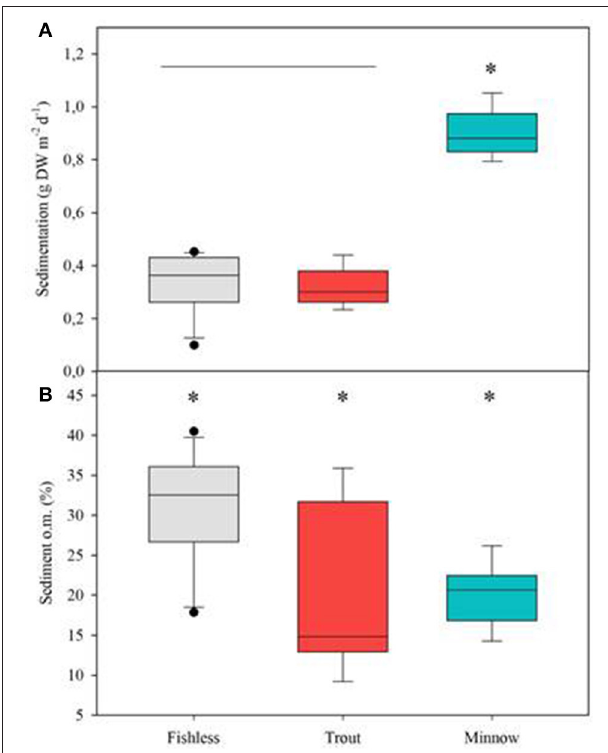
FIGURE 5 | Box plots for (A) total sedimentation, (B) sediment organic content (o.m.) in % in relation to the different scenarios: fishless, trout and minnows. Differences in the mean values are tested following the ANOVA model; var (x) = Scenario + Lake (Scenario) + error; significant differences are set at p < 0.01. Asterisks denote significantly different from the rest and the horizontal line indicates groups not significantly different.